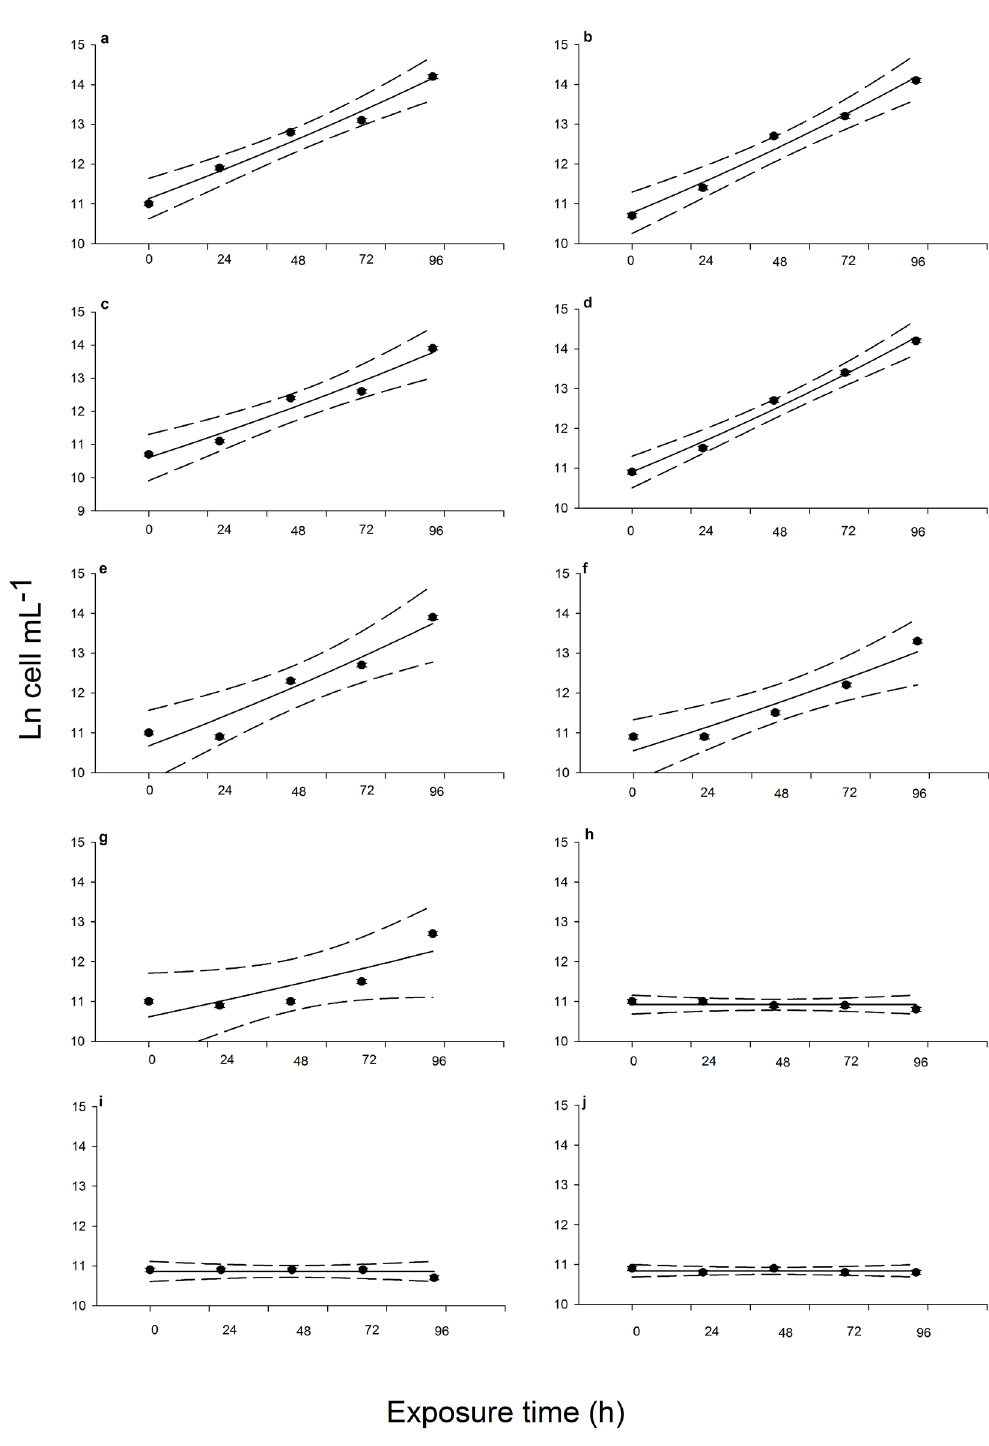
Figure 3 - R aphidocelis subcapitata density (cell mL -1 , ln) as a function of exposure time (h) for each treatment. Values represent average (± SD) of ln (cells mL -1 ). ( a ) Control (0 mg L -1 ); ( b ) 25 mg L -1 ; ( c ) 50 mg L -1 ; ( d ) 75 mg L -1 ; ( e ) 125 mg L -1 ; ( f ) 150 mg L -1 ; ( g ) 175 mg L -1 ; ( h ) 200 mg L -1 ; ( i ) 300 mg L -1 ; ( j ) 400 mg L -1 Annona glabra extract. Dashed lines represent 95% of confidence